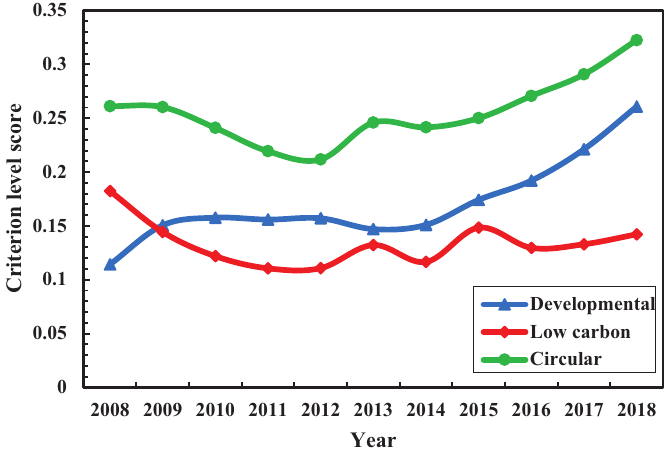
Figure 5. Measurement results for the three criterion